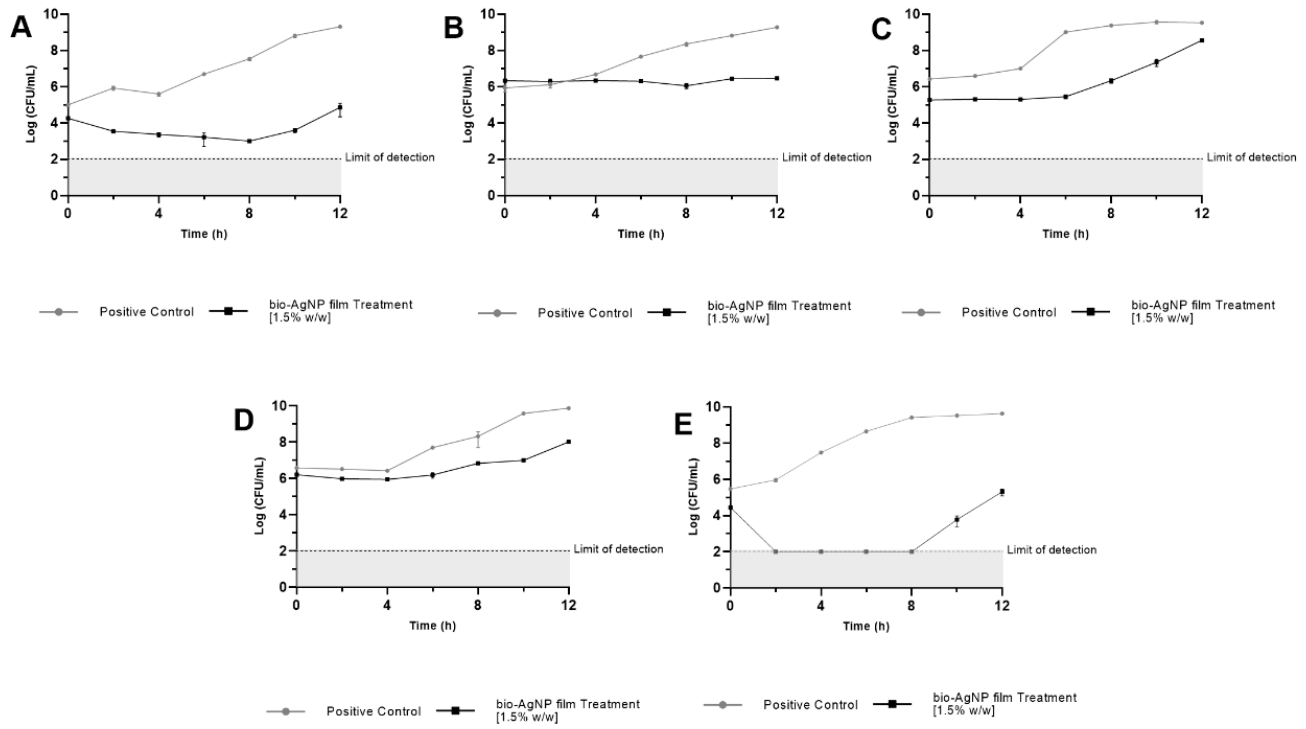
Figure 5. Growth curve of bacteria after 24 h of contact with biodegradable films with (treatment) and without bio-AgNPs (control). The data are expressed as the mean ± standard deviation of three replicates. ( A ) E. coli ATCC 25922, ( B ) S. aureus ATCC 25923, ( C ) S. Enteritidis ATCC 13076, ( D ) S . Typhimurium UK-1 ATCC 68169, and ( E ) S . Typhimurium ATCC 13311.